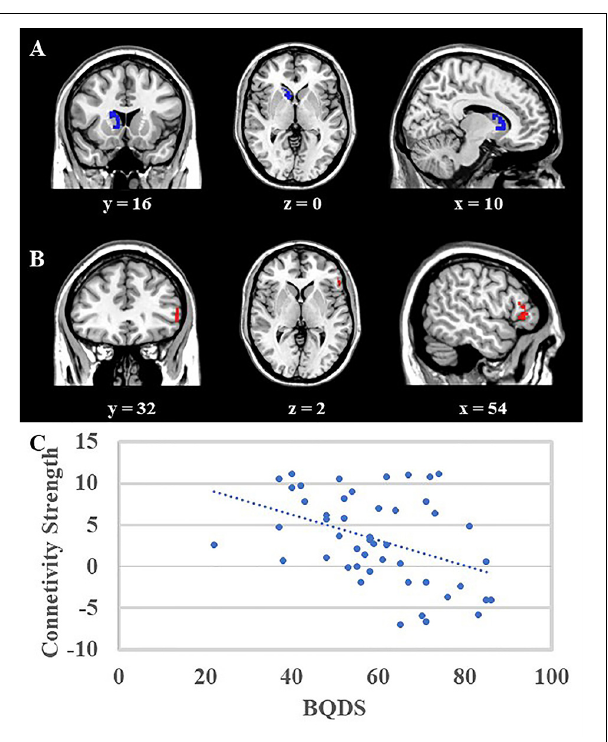
FIGURE 2 | (A) Voxel-Based Morphometry (VBM) analysis showed that the right caudate (blue area, MNI coordinates: 8, 14, − 2; 81 voxels, Z = 4.74) was negatively correlated with scores of motor impulsivity, and no other results were found. (B) Psycho-Physiological Interactions (PPI) analysis suggested that in contrast to view control images, viewing BQ related images would decrease functional connectivity between right caudate and right DLPFC (red area, MNI coordinates: 54, 28, − 2, 57 voxels, Z = 4.38). Both results were mapped onto a standard brain and displayed with coronal, axial, and sagittal views respectively. The numbers below represented the slice numbers. (C) The scatter plot of correlation analysis between functional connectivity (right caudate and right DLPFC) and BQDS scores in the BQD